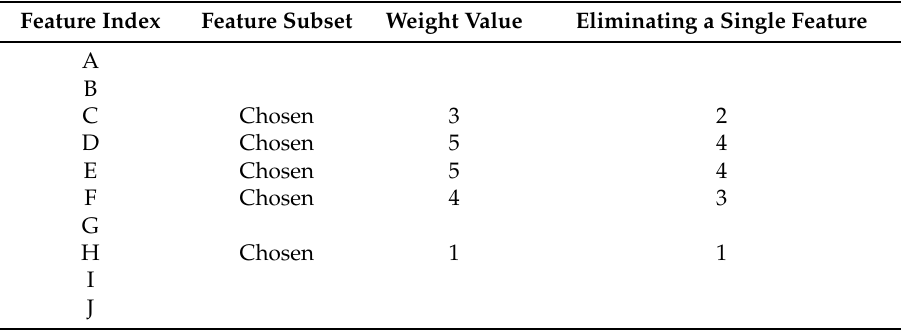
Table 3. The weight values and ranking of selected features of Figure